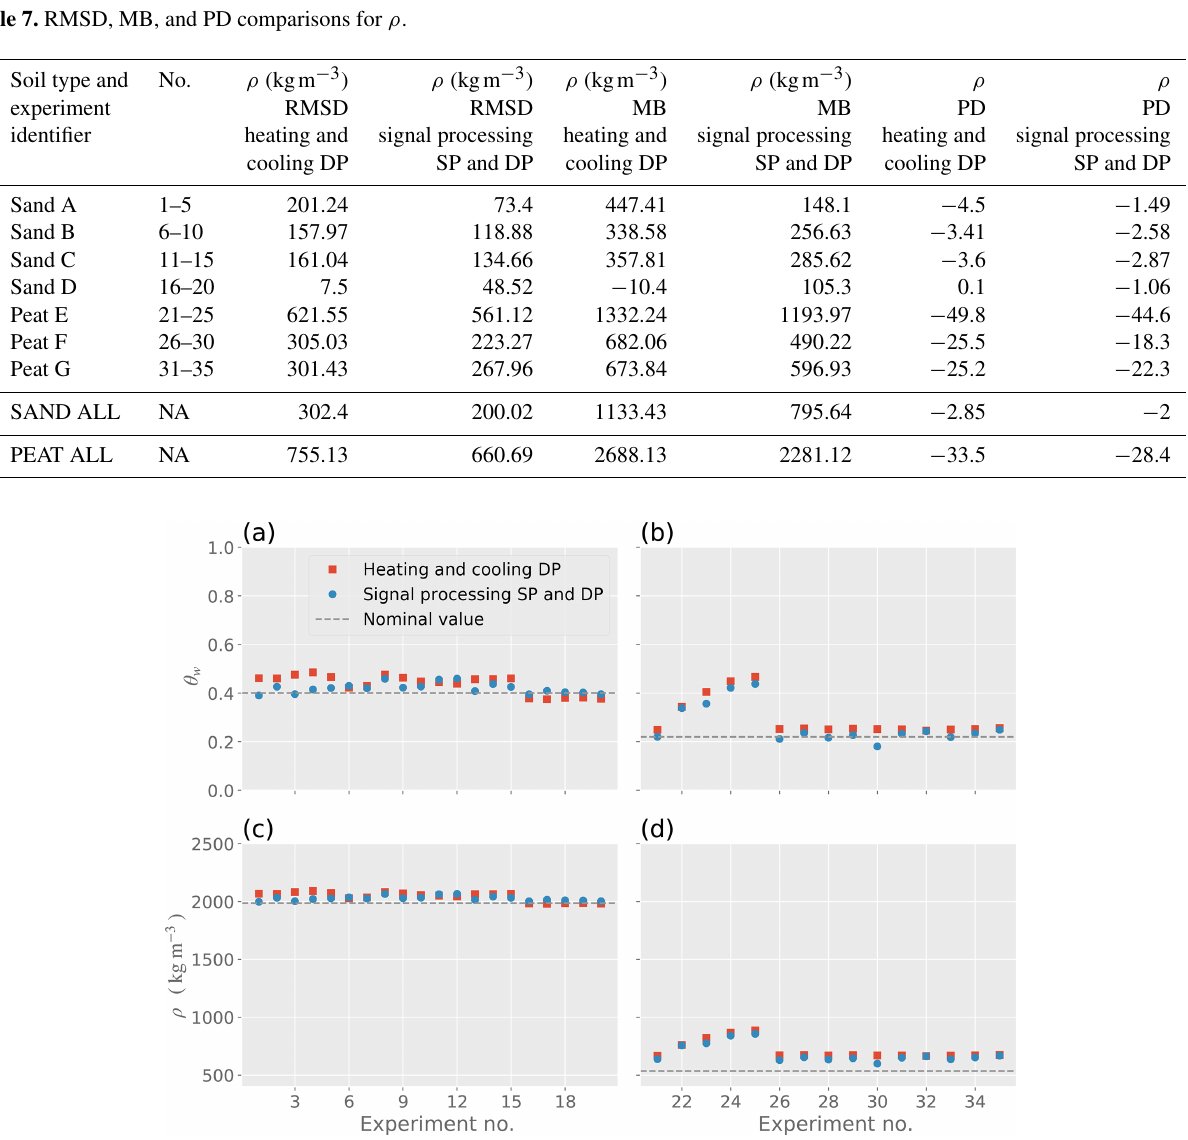
Figure 8. Water content θ w and density ρ for each of the experiments. (a) Water content for sand. (b) Water content for peat. (c) Density for sand. (d) Density for